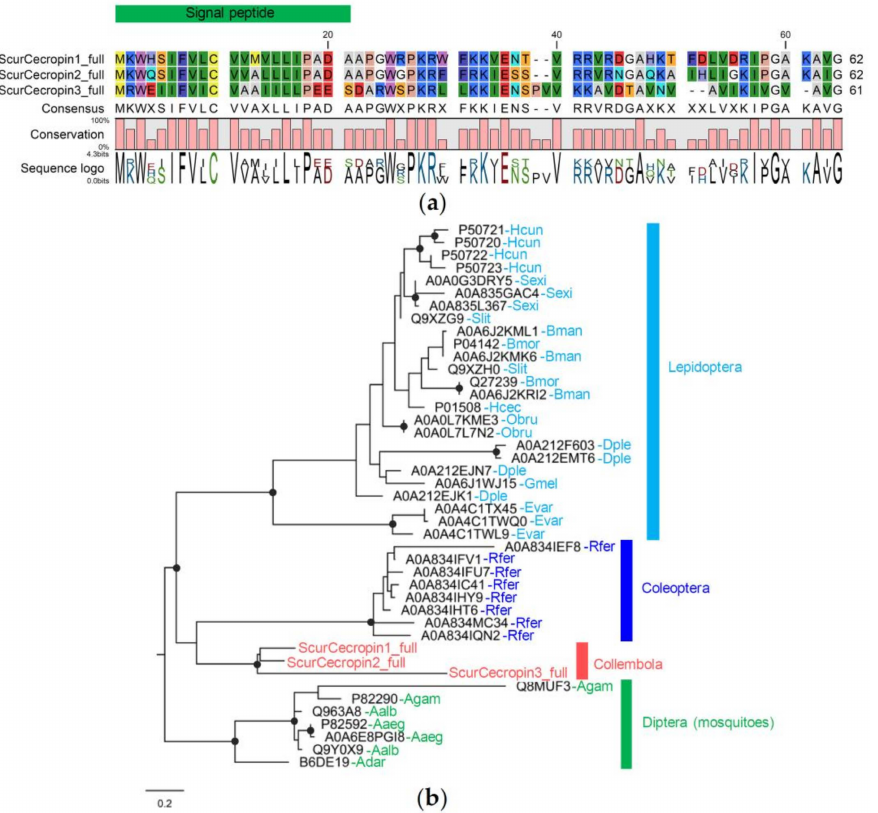
Figure 6. Sequence alignment and phylogenetic relationships of collembola cecropins: ( a ) protein alignment; ( b ) Phylogenetic tree of arthropod cecropins. Branch supports (aLRT) higher than 0.9 were indicated with black dots on tree nodes (Abbreviation: Scur = Si. curviseta , Hcun = Hyphantria cunea , Sexi = Spodoptera exigua , Slit = Spodoptera litura , Bman = Bombyx mandarina , Bmor = B. mori , Hcec = Hyalophora cecropia , Obru = Operophtera brumata , Dple = Danaus plexippus , Gmel = Galleria mellonella , Evar = Eumeta variegata , Rfer = Rhynchophorus ferrugineus , Agam = Anopheles gambiae , Adar = A. darlingi , Aalb = Aedes albopictus , Aaeg = A. aegypti